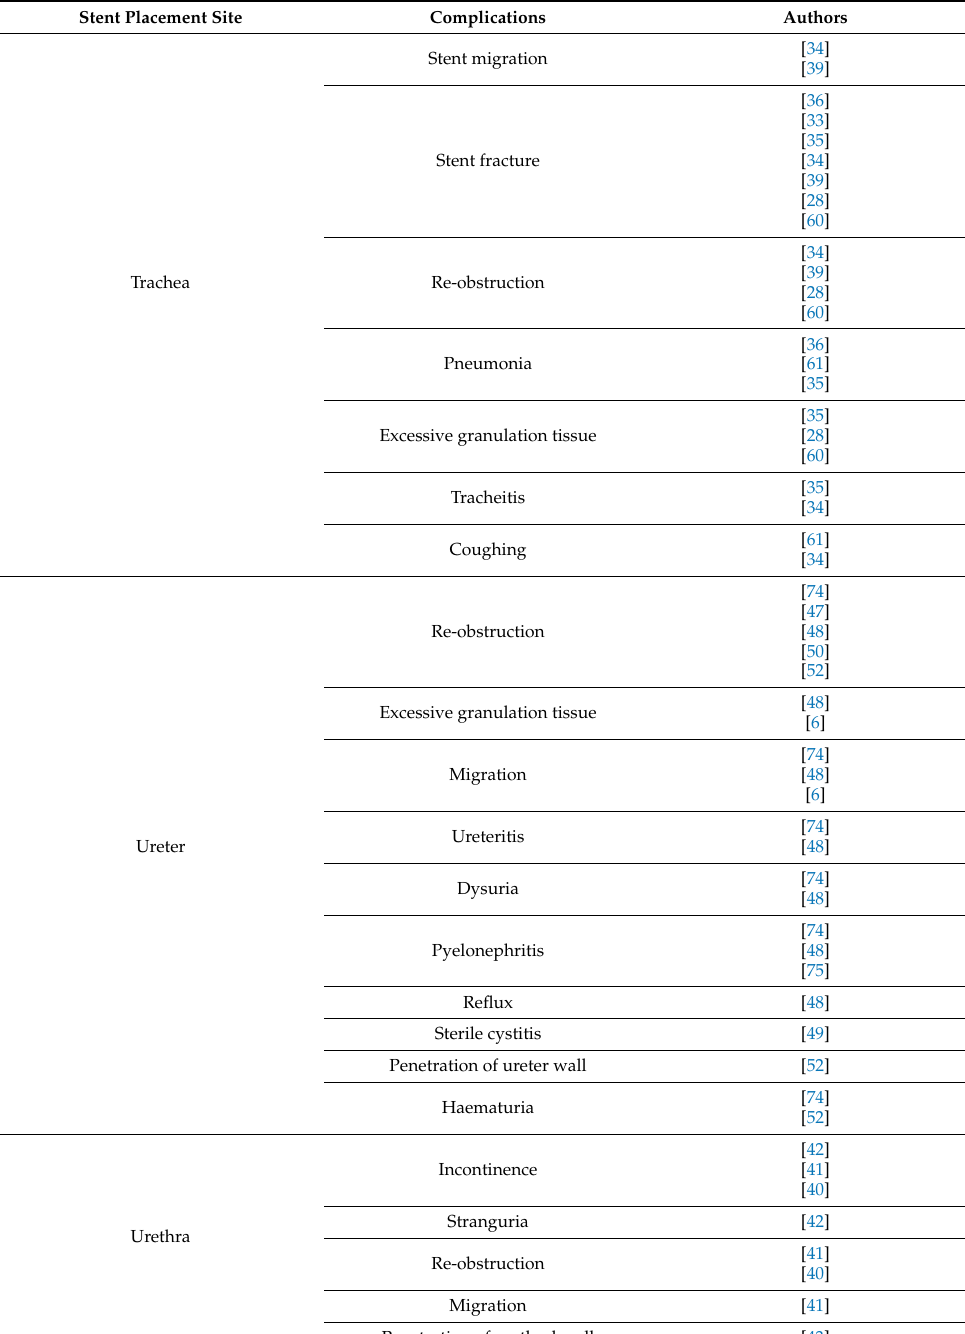
Table 2. Some complications after the stent placement